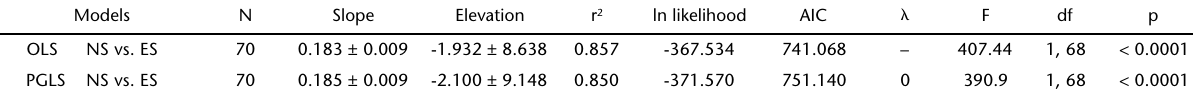
Table 3. Regressions of nuclear sizes (NS) on erythrocyte size (ES) in amphibians based on ordinary least squares (OLS) regression and phylogenetic generalized least squares (PGLS) regression. Significant associations between variables are shown in bold.